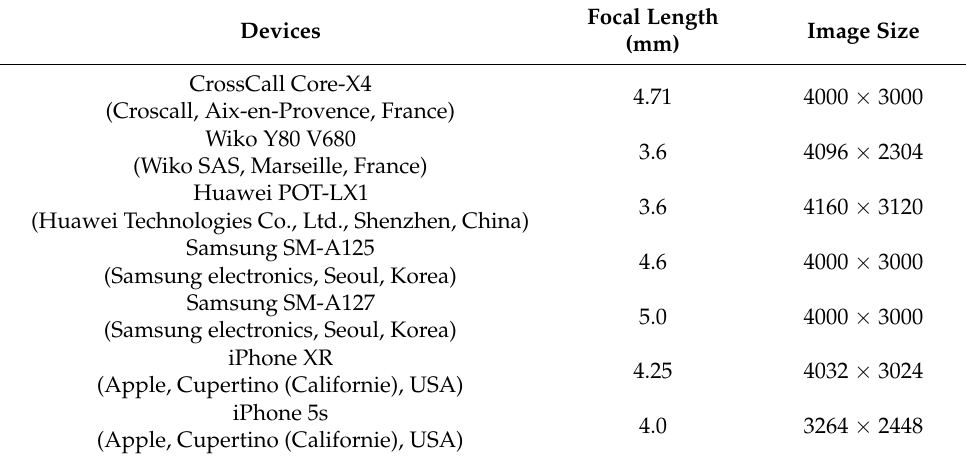
Table 1. Smartphone devices used during the simulation of crowd-sourced